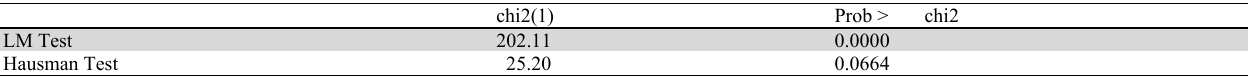
LM test and Hausman Test